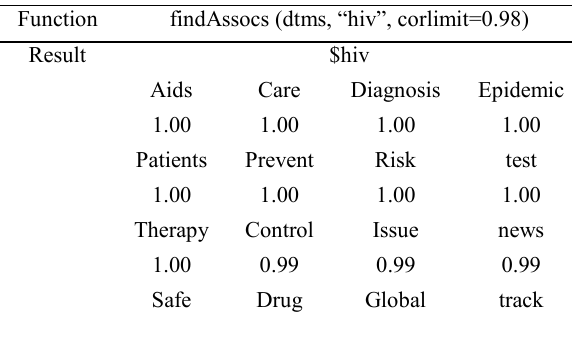
Table 10. Association between the hiv ailments with 98% correlation